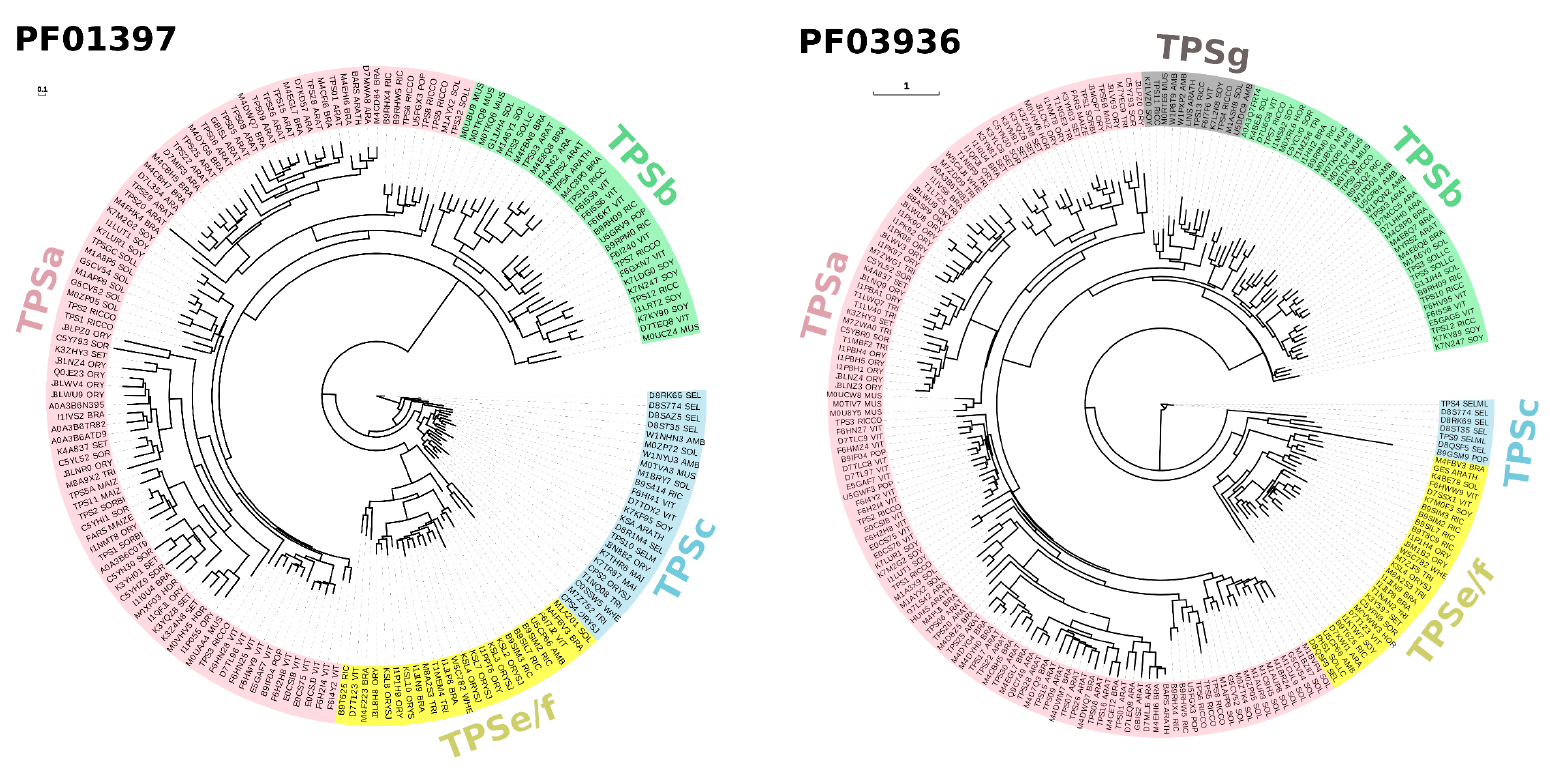
Figure 2. Phylogenetic classification of terpene synthases (TPSs) based on PFAM PF01397 and PF03936 SEED alignments reconstructed using PhyML 3.0 maximum likelihood method [30,31]. Automatic model selection was based on Smart Model Selection (SMS) in PhyML [32], while the aLRT SH-like algorithm was used in place of bootstrap analysis. TPS protein sequences were classified into subfamilies using Terzyme [33]. The resulting phylogenetic trees were visualized using Evolview v3 [34]. PFAM Accession numbers/IDs are indicated at the leaf nodes, with corresponding background colors representing TPS gene subfamily affiliations. Bars (0.1 and 1) indicate mean amino acid substitution per site.